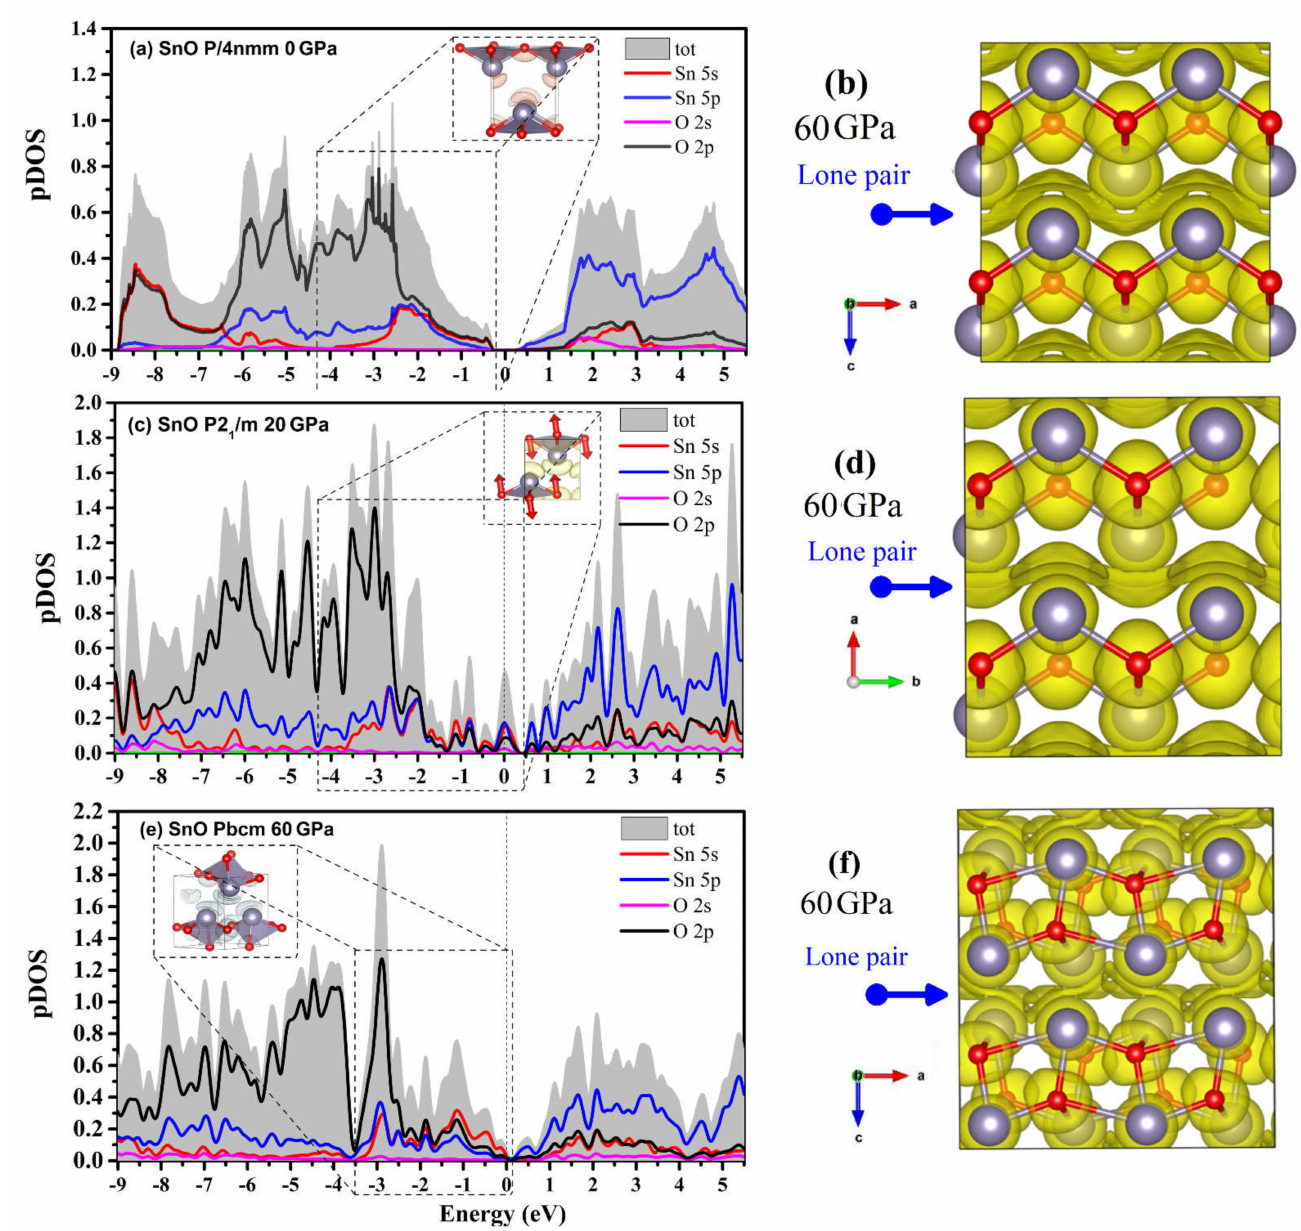
Figure 13. pDOS and the lone pairs of three polymorphs of SnO. The marked region indicates the hybridization of the Sn–O states of lone pairs via ILDOS. The electron localization function for a supercell of two layers of each structure is calculated at 60 GPa. The ELF and ILDOS iso-surface levels are set at 0.15 e/Å 3 and 0.006 e/Å 3 , respectively: ( a ) pDOS and ILDOS of P4/nmm SnO at 0 GPa; ( b ) ELF of P4/nmm SnO at 60 GPa; ( c ) pDOS and ILDOS of P2 1 /m SnO at 20 GPa; ( d ) ELF of P2 1 /m SnO at 60 GPa; ( e ) pDOS and ILDOS of Pbcm SnO at 60 GPa; ( f ) ELF of Pbcm SnO at 60